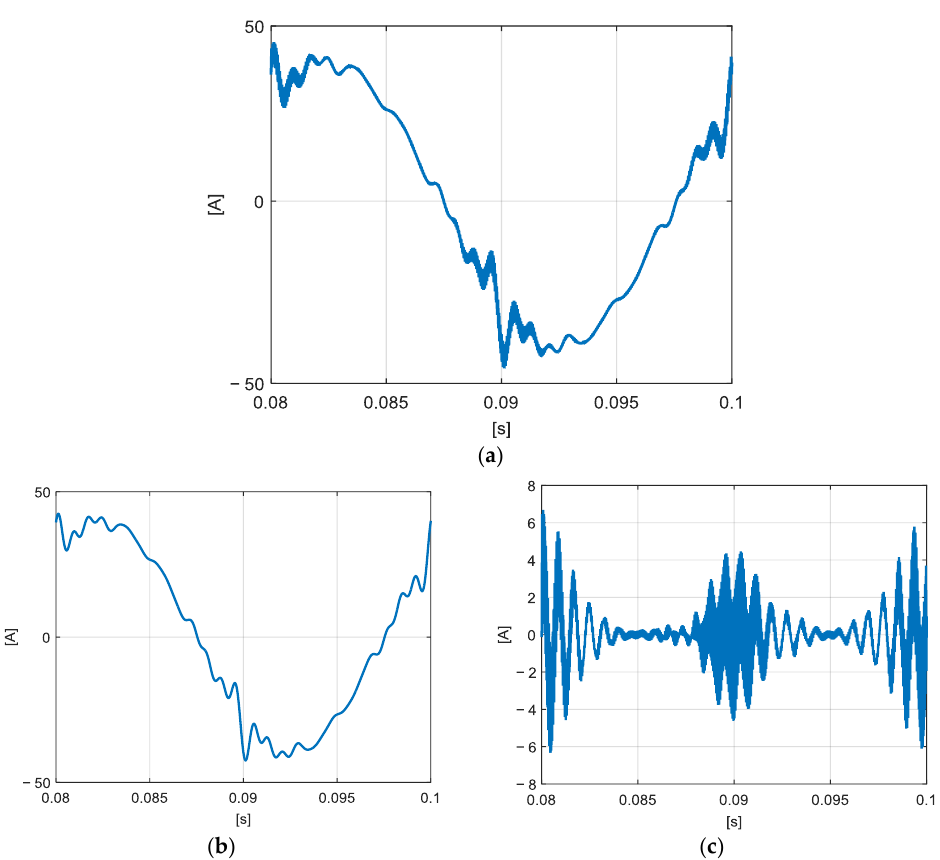
Figure 2. Case study 1: time trend of the waveform under study in terms of ( a ) original waveform, ( b ) low-frequency waveform, and ( c ) high-frequency waveform.